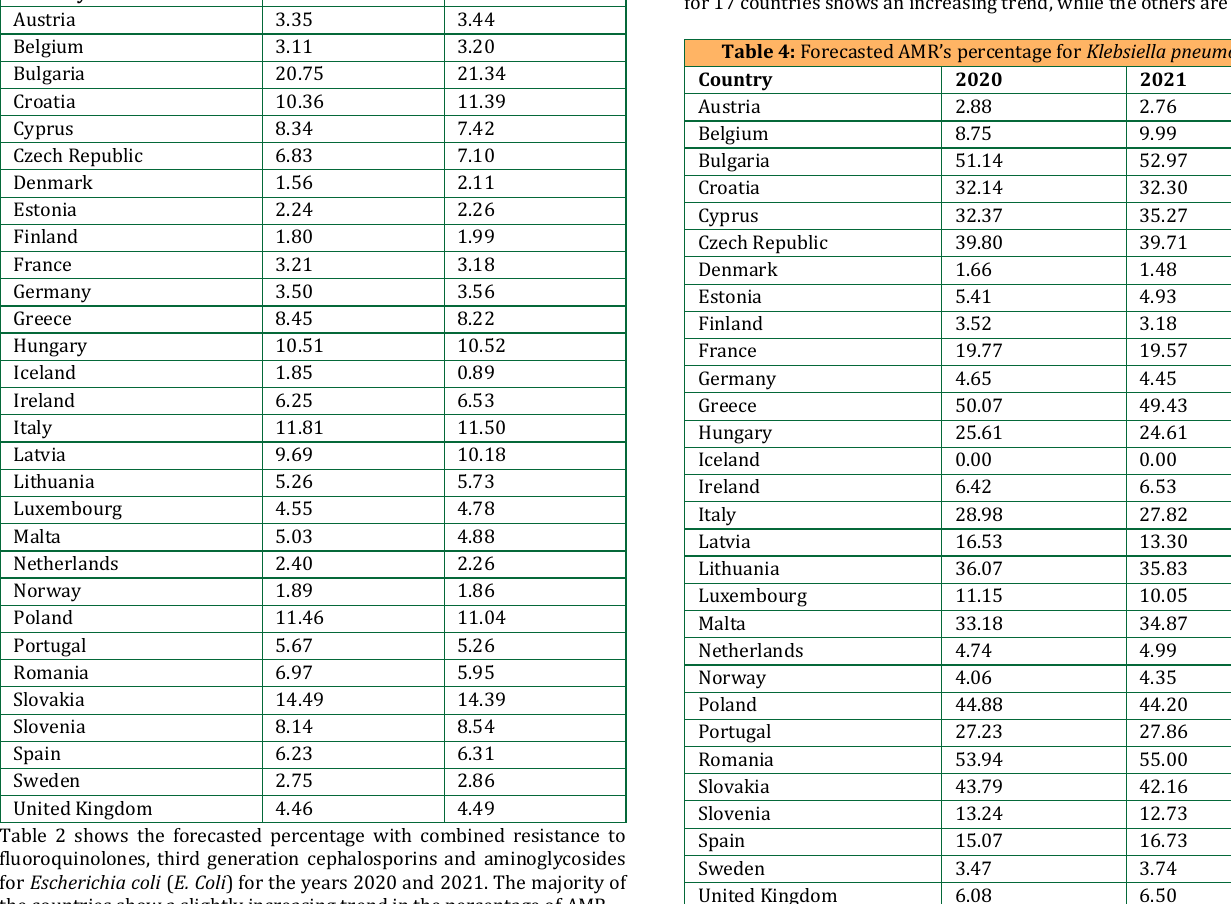
Table 2: Forecasted AMR’s percentage for Escherichia coli Country